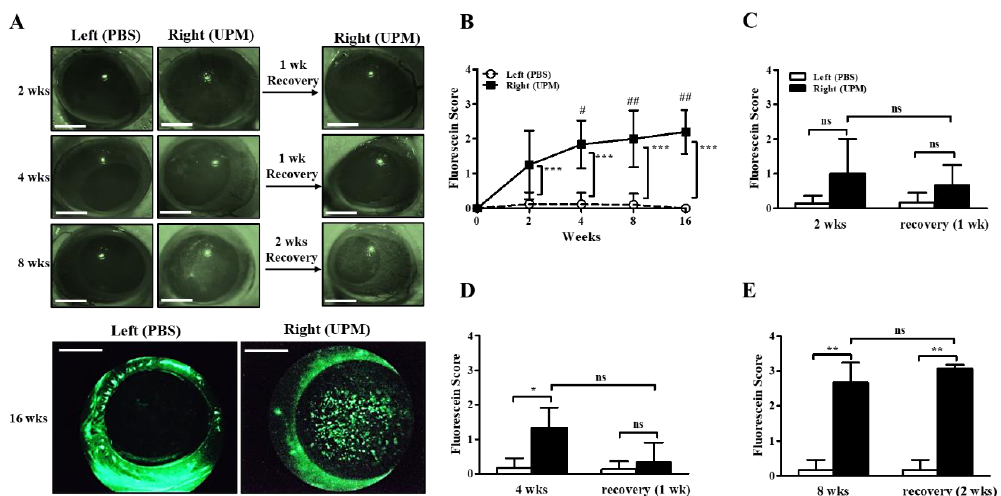
Figure 2. Effect of UPM on the corneal surface according to exposure period. Injury to the corneal surface was determined by fluorescein staining, and its levels were expressed as scores. ( A ) Photographs of fluorescein-stained eyes acquired at 2, 4, 8 and 16 weeks after applying UPM or PBS to the right or left eye. Additional photographs were also acquired after one or two weeks of rest at 2, 4 and 8 weeks. The scale bars indicate 2 mm. ( B ) Fluorescein scores were determined from images at 2, 4, 8 and 16 weeks. Fluorescein scores after one week of rest at 2 weeks ( C ) or 4 weeks ( D ) and after two weeks of rest at 8 weeks ( E ) are shown. Data are expressed as the mean ± SD. * p < 0.05, ** p < 0.01, *** p < 0.001 vs. left eye at the same time point; # p < 0.05, ## p < 0.01 vs. right eye at 2 weeks; ns, not significant.